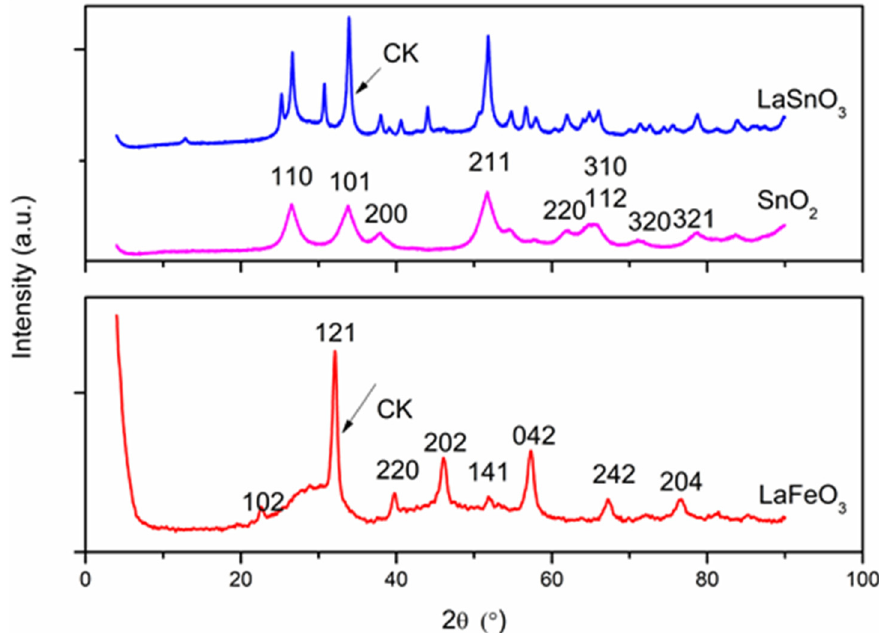
Figure 1. XRD patterns of LaFeO 3 , LaSnO 3 (vertically translated by 5661.3 a.u.), and SnO 2 .